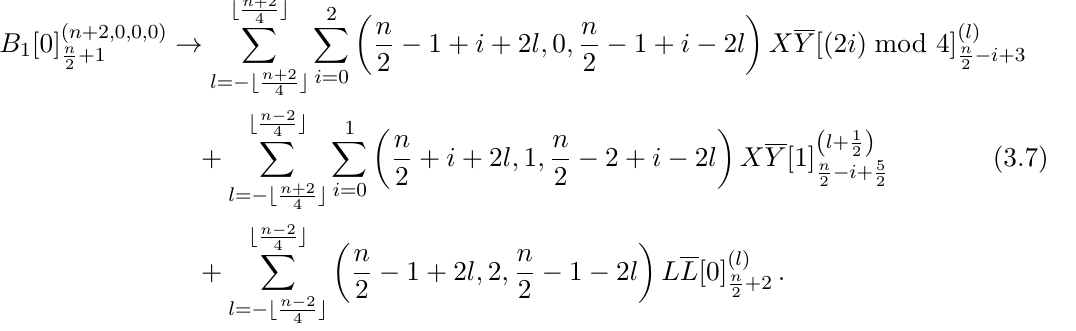
B [0] ( n +2 , 0 , 0 , 0) 1